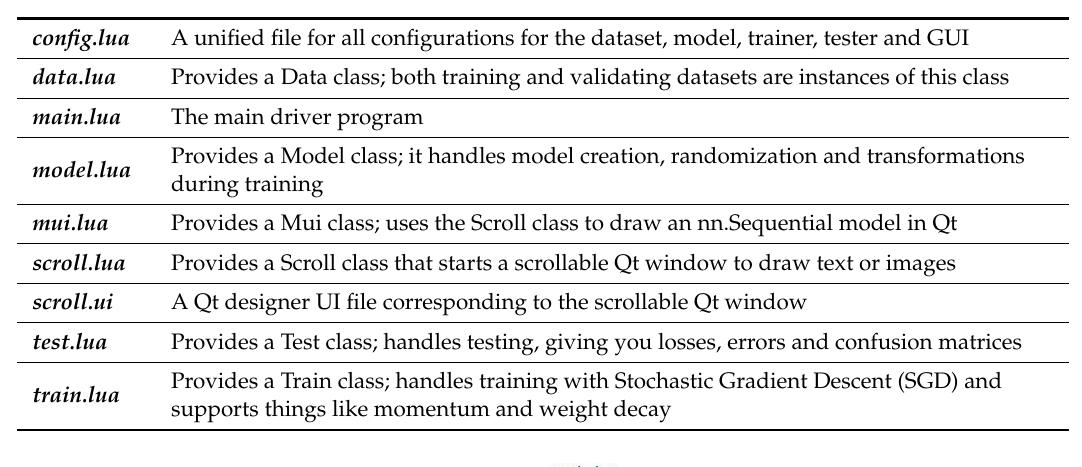
Table A3. Training programs for Crepe.